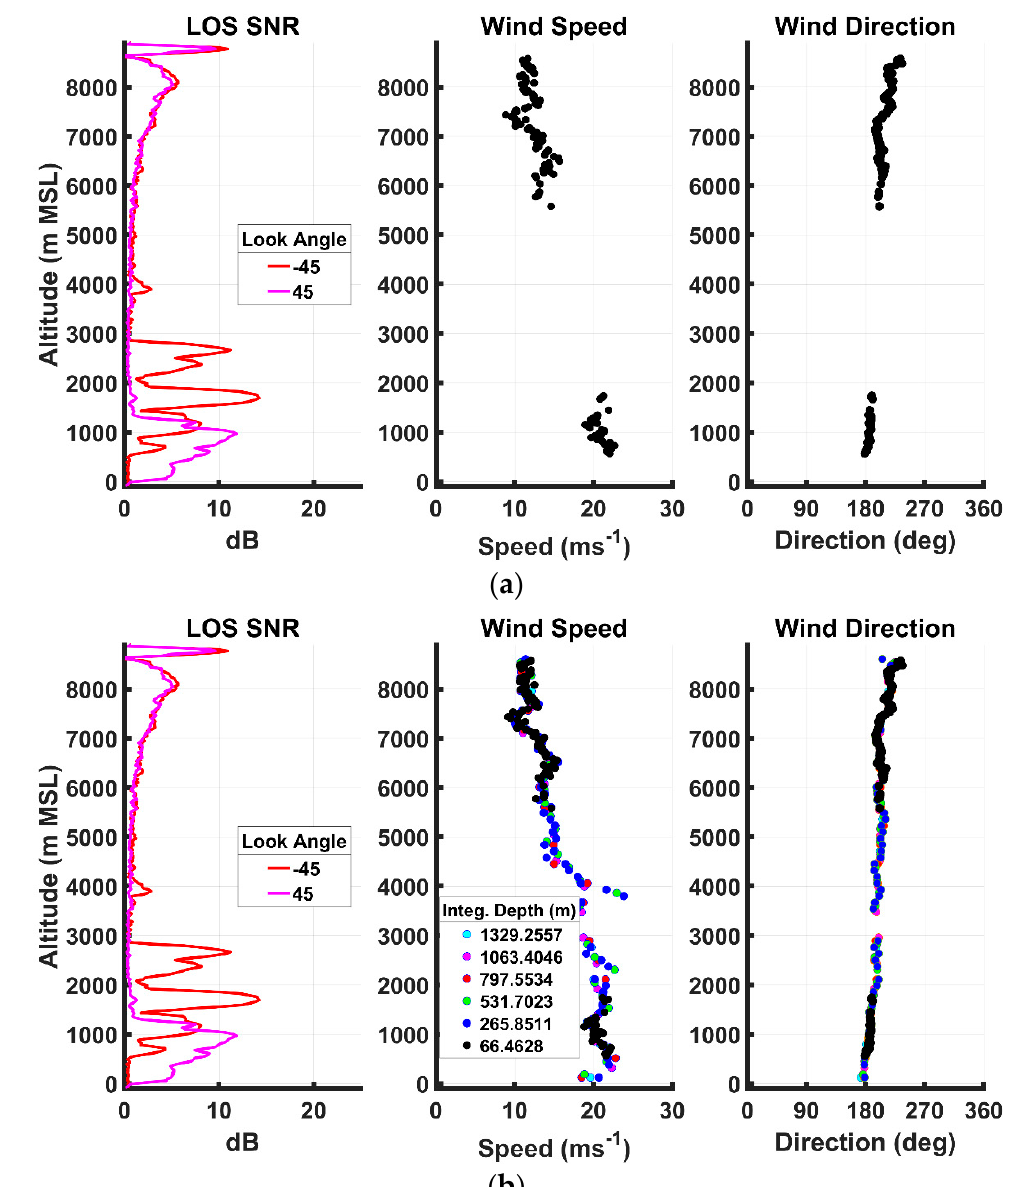
Figure 5. DAWN base vertical profiles of SNR, wind speed and wind direction processed with a single range gate ( a ) and adaptive integration over 5 integration depths ( b ) for the stronger wind case of 20 June 2017 204218Z.